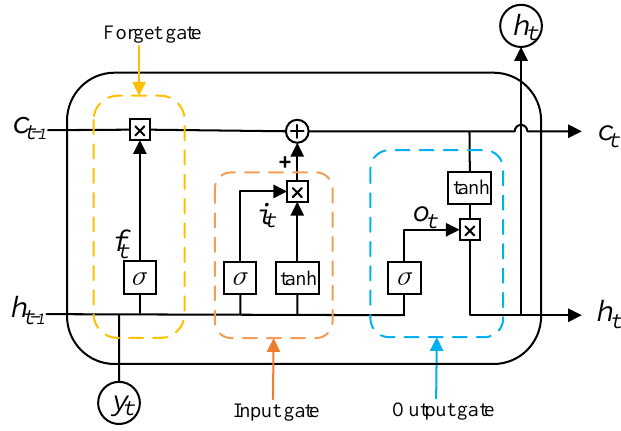
Figure 6. Basic structure of Long Short-Term Memory (LSTM).